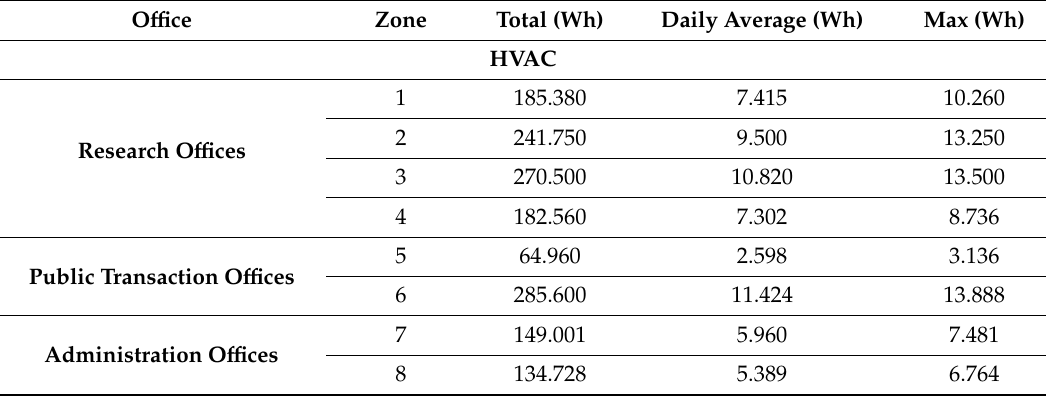
Table 3. HVAC, lighting and device consumption (1-month